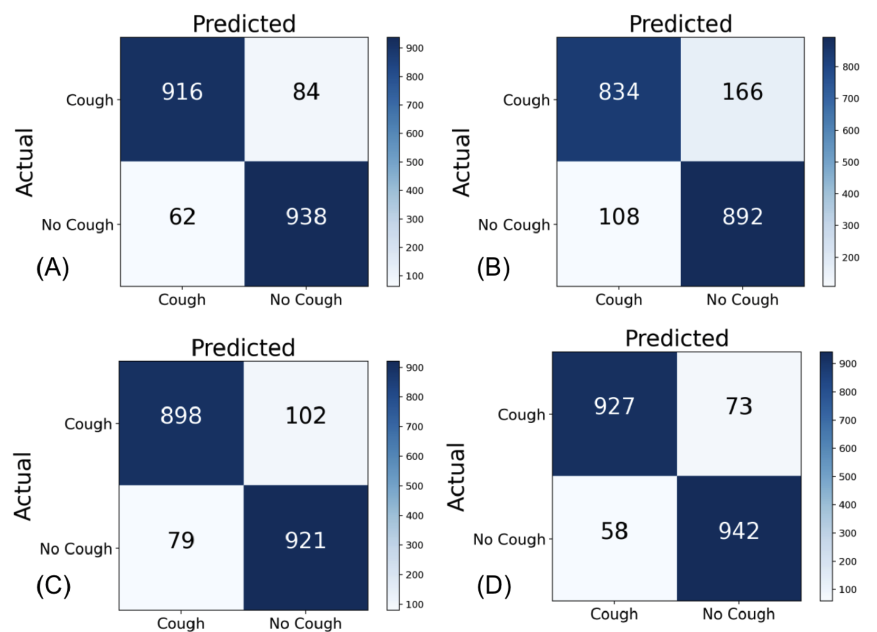
Figure 6. Confusions Matrices, created using MatPlotLib, for ( A ) CNN, ( B ) RNN, ( C ) CRNN, and ( D ) the proposed STAIN machine learning models. The new STAIN architecture outperforms the traditional neural network architectures for more accurate cough detection.